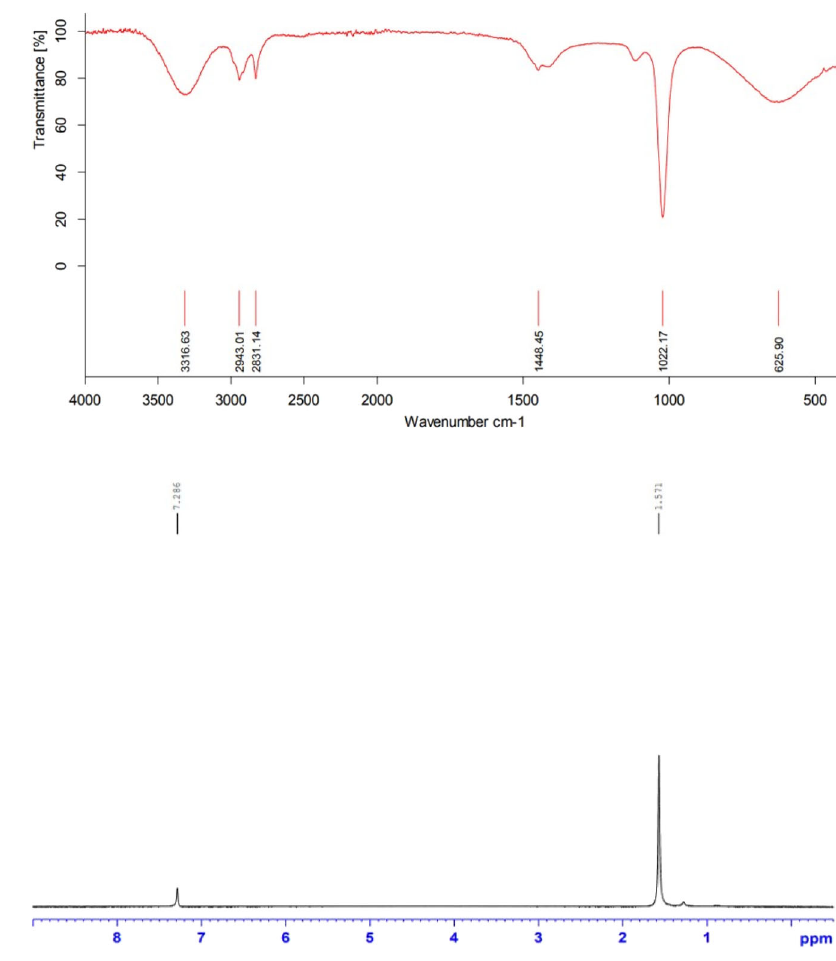
Fig. 1 FT-IR of CuO/GO nanocomposites